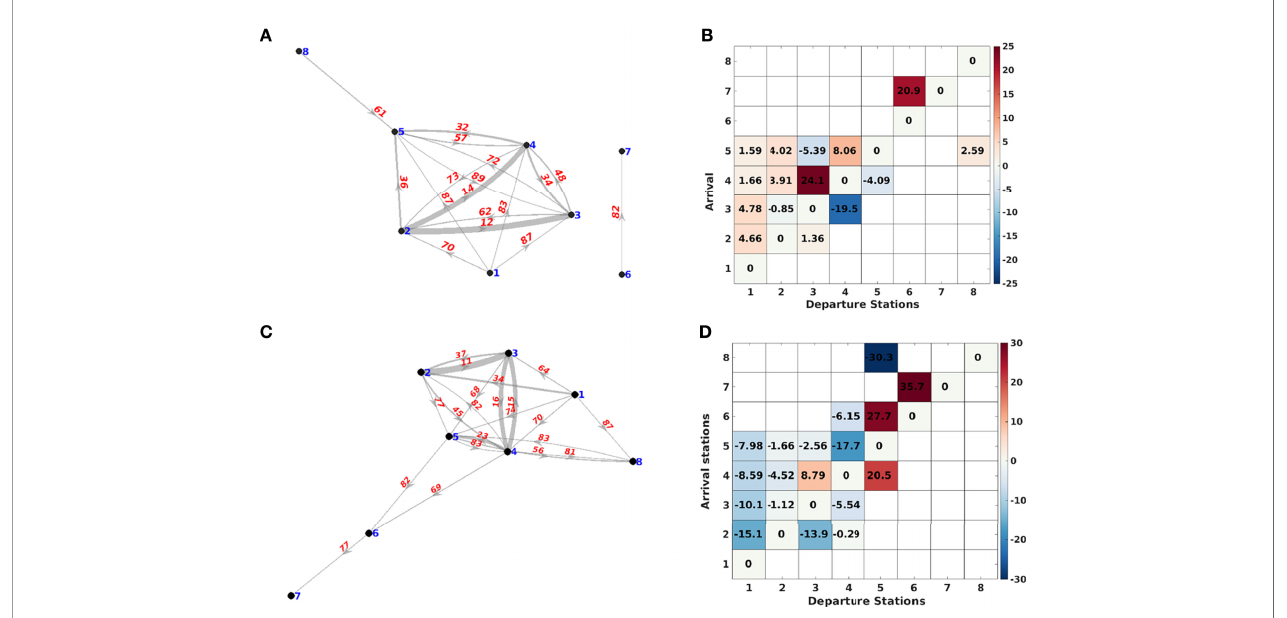
FIGURE 3 | (A) Dinophysis connectivity network showing the mean “ min transit time ” (days) between the departure stations and the arrival stations in spring 2011, (B) Difference between the “ mean transit time ” values during spring 2011, 2013 (2011-2013), (C) Dinophysis connectivity network showing the “ mean transit time ” (days) between the departure stations and the arrival stations in winter 2011, (D) Difference between the “ mean transit time ” values during winter 2011, 2013 (2011- 2013). A graphical representation of connectivity times keeping geographical distances between node is illustrated in Figure S4 .